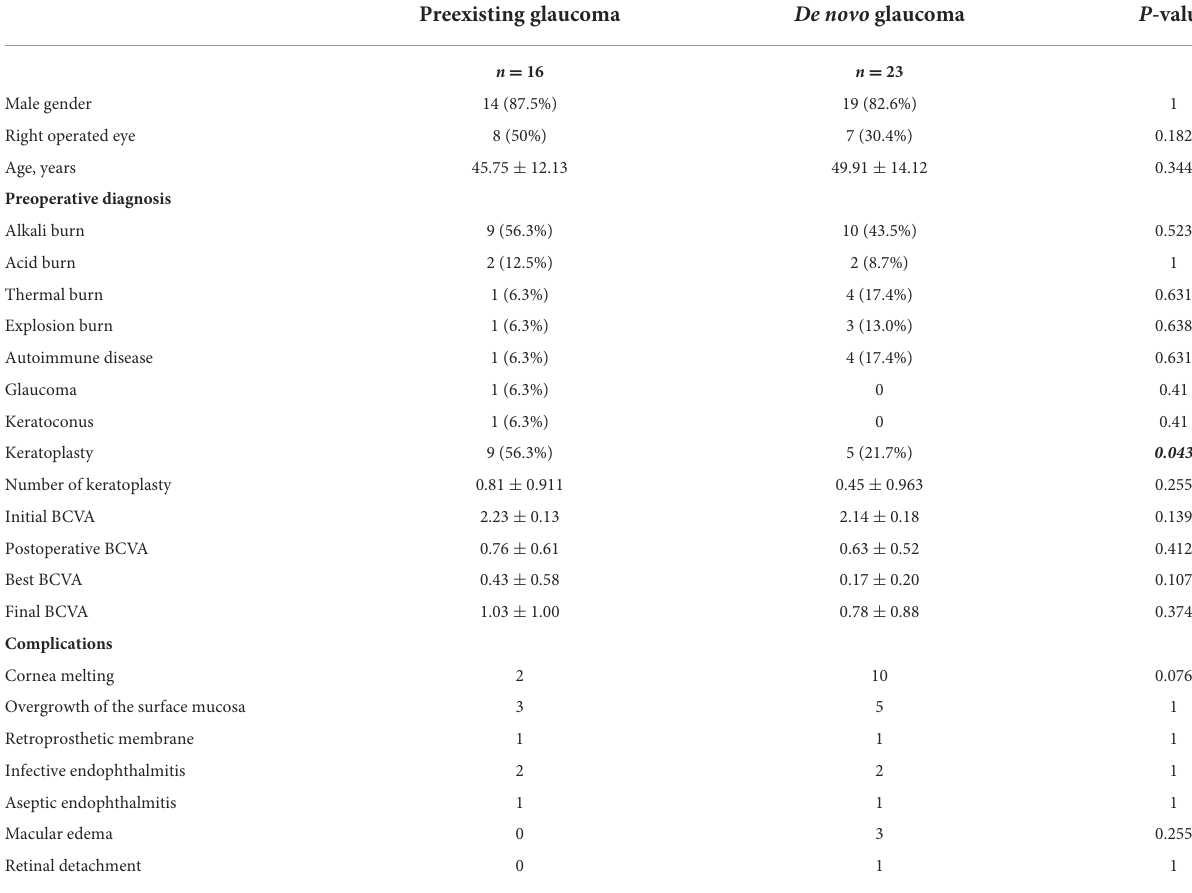
TABLE 1 Comparison of related data between preexisting glaucoma and de novo